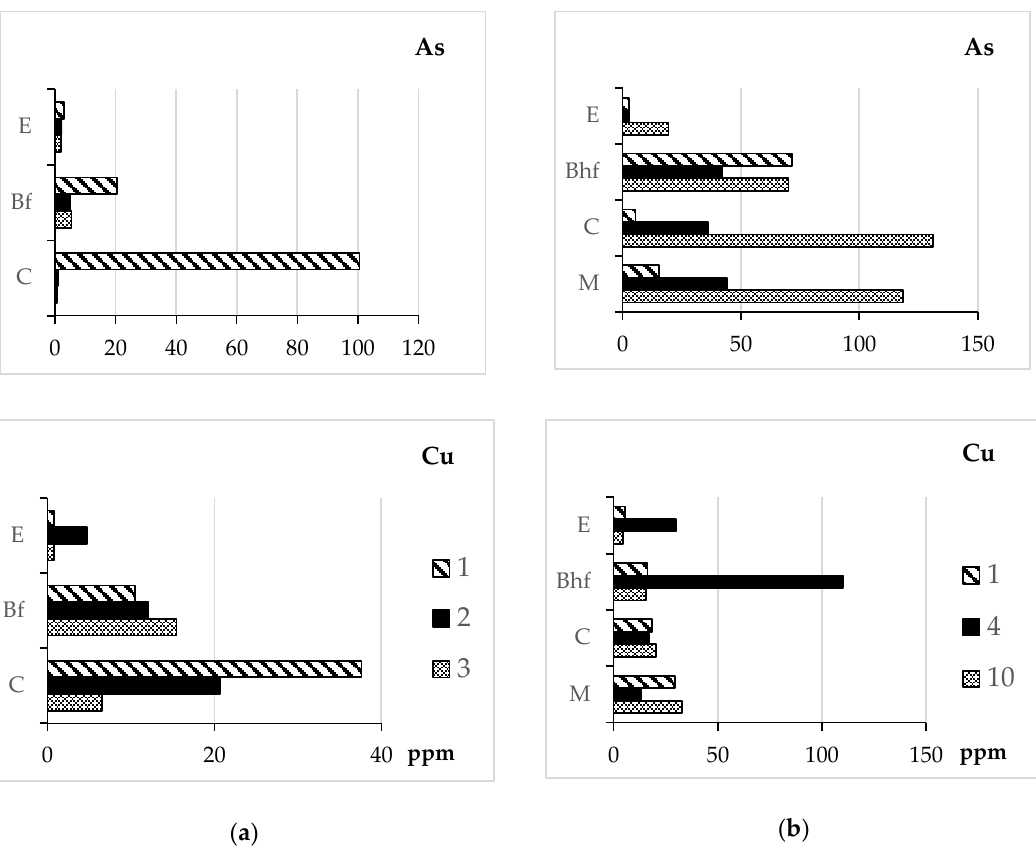
Figure 5. Distribution of arsenic and copper mobile forms in surface sediment horizons within different profiles: ( a ) 1—over the mineralized zone, 2—over the circum-ore zone, 3—out of the mineralized zone; ( b ) 1,4,10—profiles in the Piilola prospecting area.